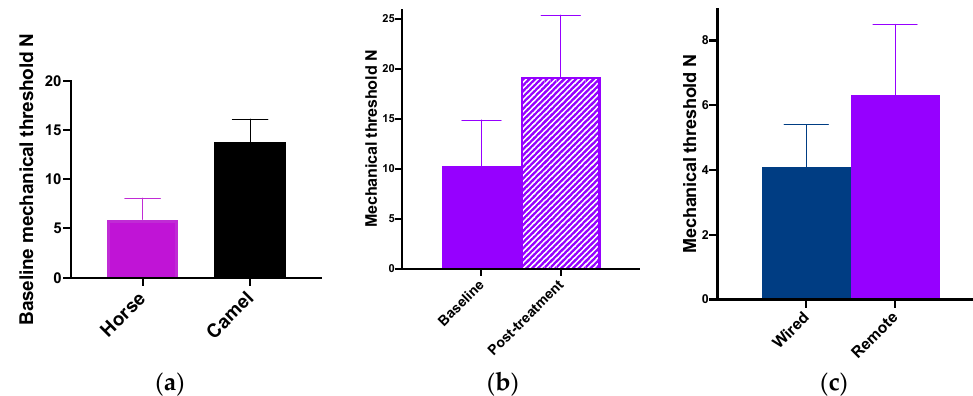
Figure 10. ( a ) Mean ± SD baseline (no treatment) mechanical nociceptive thresholds (MTs) (N) measured on a leg in horses ( n = 14) and camels ( n = 3). ( b ) Mean ± SD pre treatment and peak post analgesic treatment (see text for detail) MTs (N) measured on a foreleg in four horses using a 3-pin actuator. ( c ) Mean ± SD baseline (no treatment) MTs (N) measured on a foreleg of 4 horses with a wired system (close proximity and contact with the tester) and with the infra-red remote controlled system (horse unrestrained and tester outside the stall). Measurements with each system were made within less than 5 min.